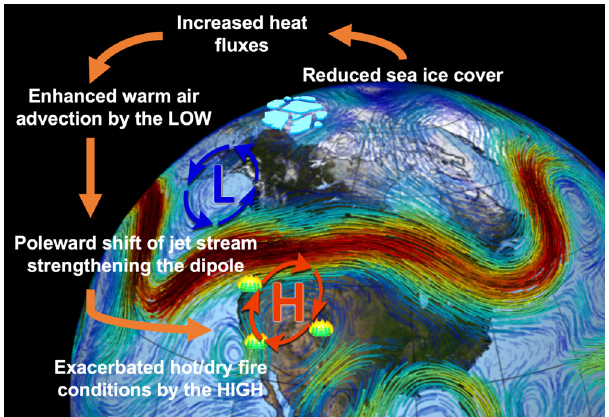
Fig. 5 A schematic diagram for the teleconnection between Arctic sea-ice loss and increasing fi re hazards over the western U.S. The L and H denote the cyclonic low pressure and anticyclonic high pressure circulation anomalies, respectively, induced by preceding Arctic sea-ice loss as suggested by the CESM-RESFire model sensitivity results shown in Fig. 2a. (Background image by NASA/Goddard Space Flight Center Scienti fi c Visualization